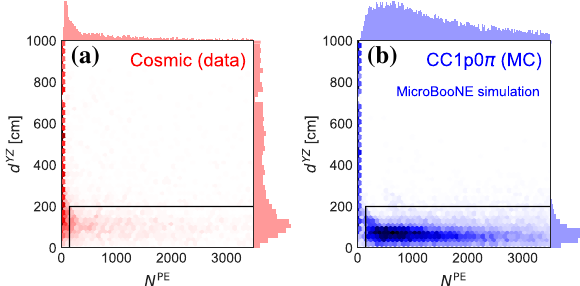
Fig. 4 The distribution of the two-dimensional distance of the recon- structed vertex to the associated flash, vs. the number of photoelectrons (PE) recorded in the flash in: a cosmic data, and b simulated CC1 p 0 π events. Also shown are the one-dimensional projections of the distribu-